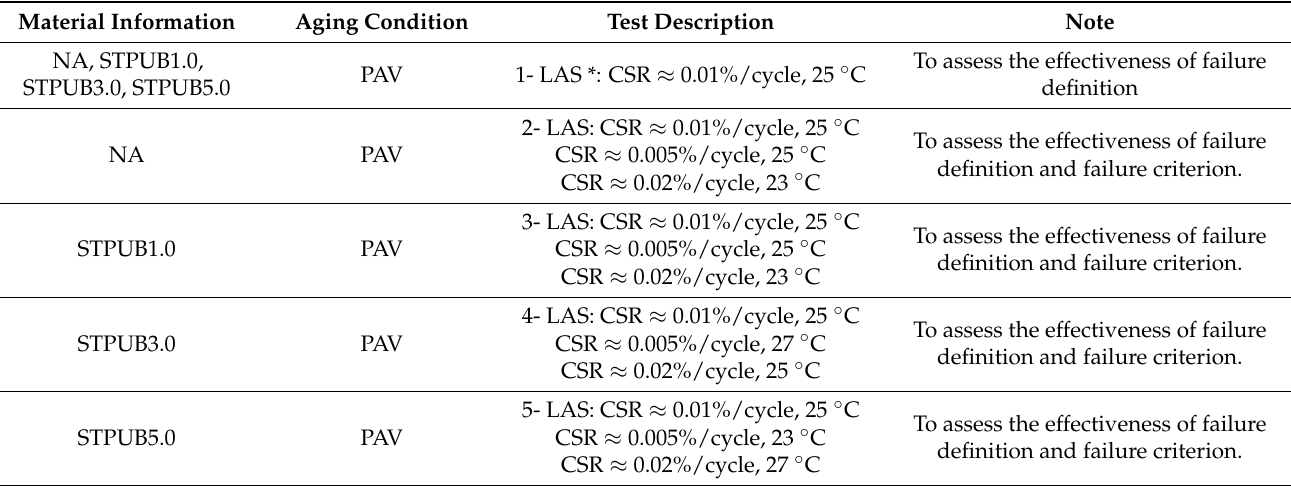
Table 3. Fatigue test